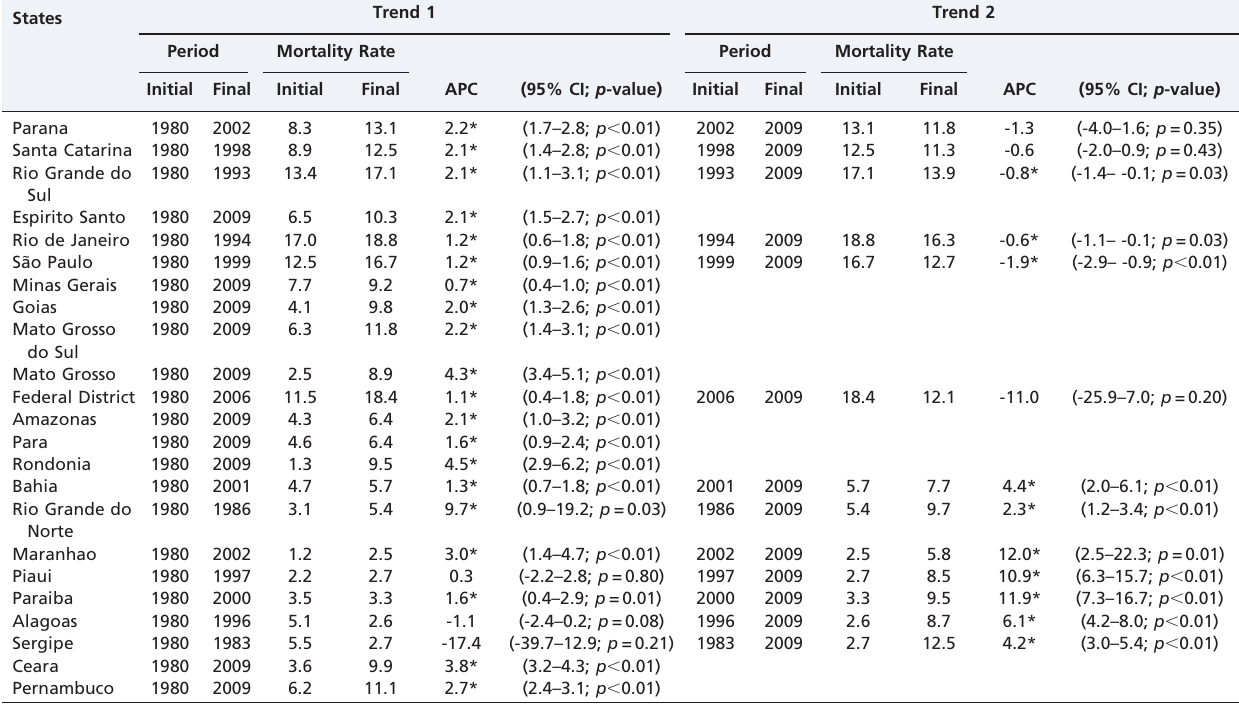
Table 2 - Trends in female breast cancer mortality rates between 1980 and 2009 in the states of Brazil. States Trend 1 Trend 2 Period Mortality Rate Period Mortality Rate